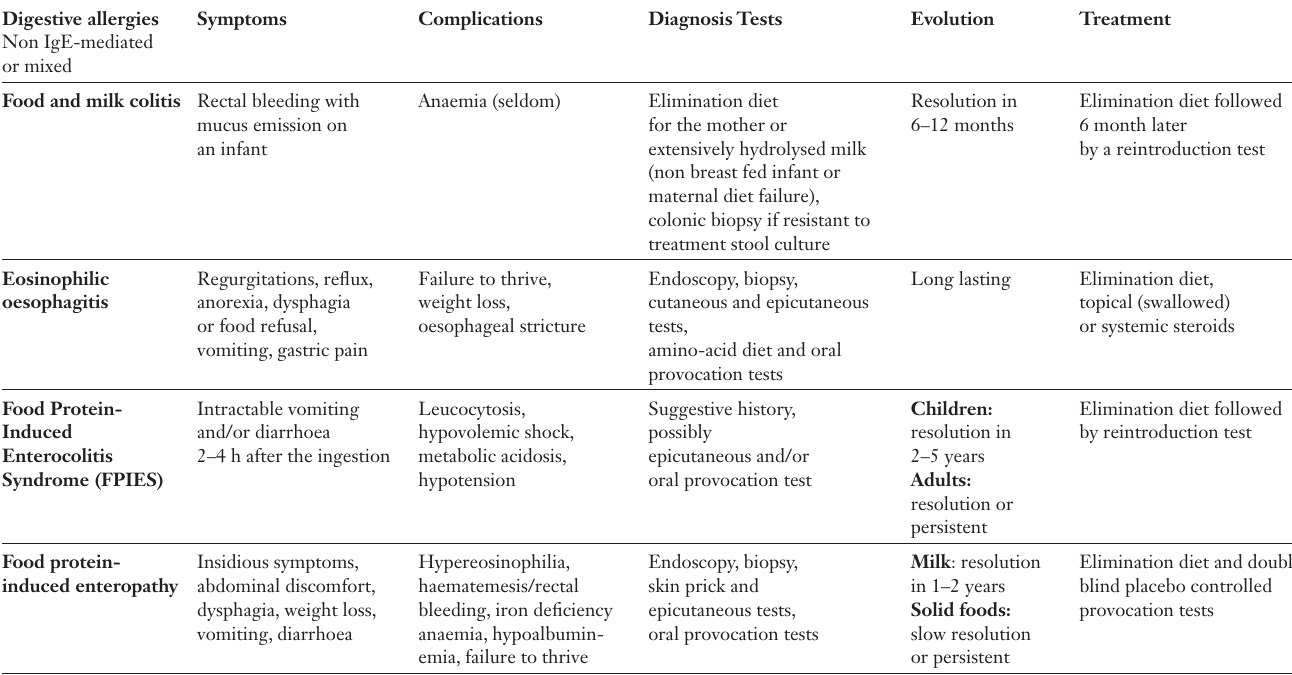
Non-IgE-mediated food